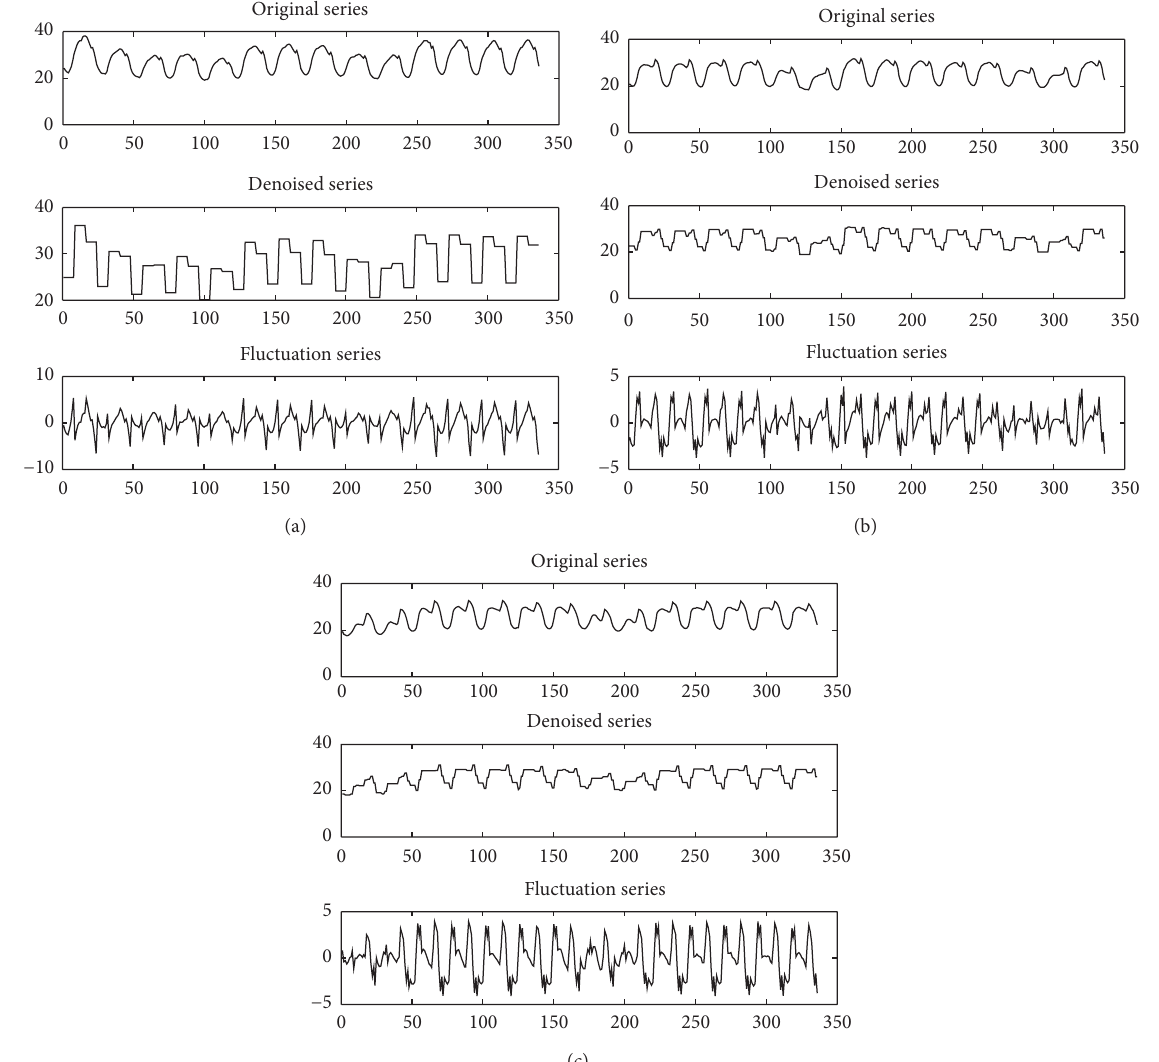
Figure 3: (a) Original series, denoised series, and fluctuation series of two weeks in summer. (b) Original series, denoised series, and fluctuation series of two weeks in spring. (c) Original series, denoised series, and fluctuation series of two weeks in